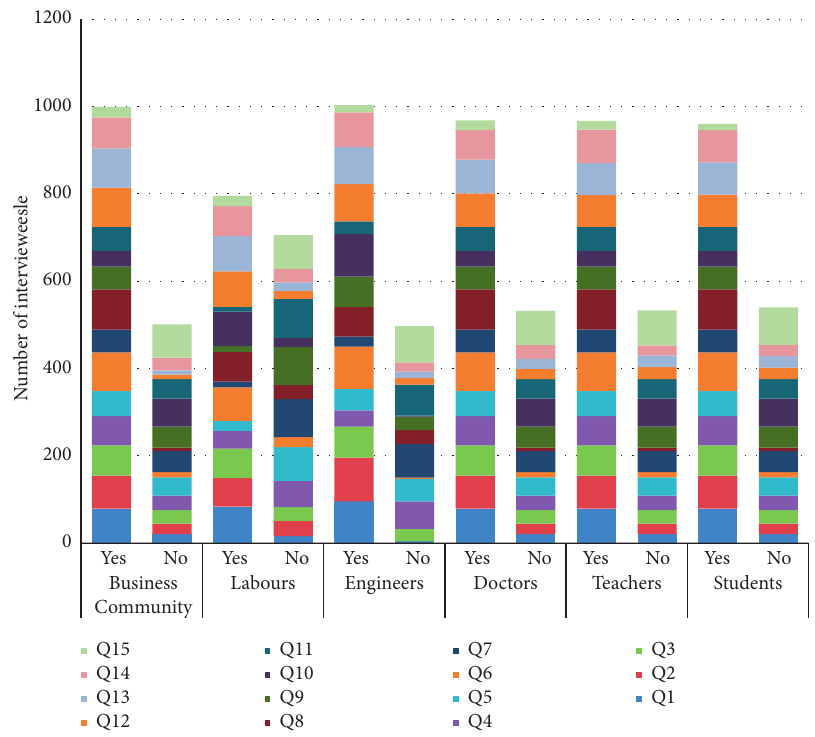
Figure 2: Comparison of the answers given by group interviewed.